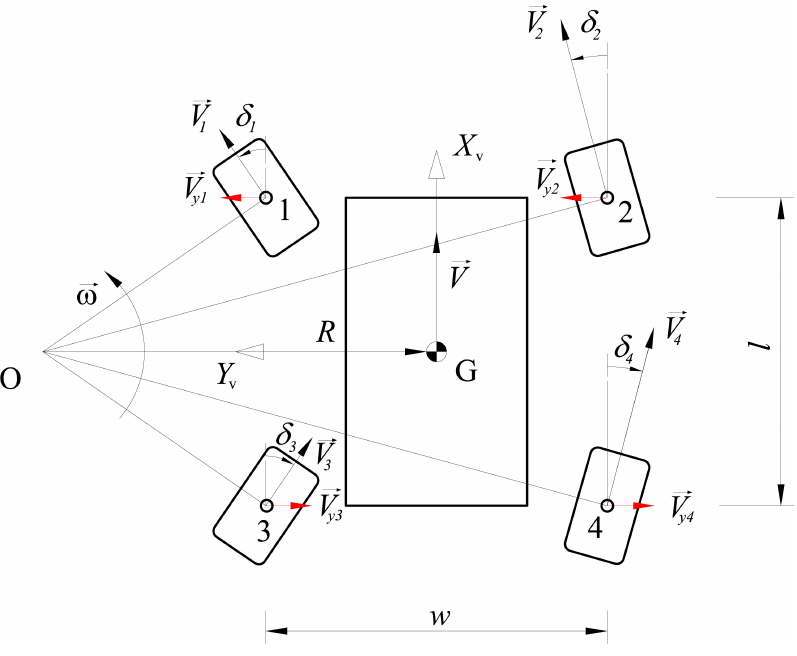
Figure 2. A four-wheel-drive/four-wheel steer mobile robot. Note that all velocity vectors are drawn to